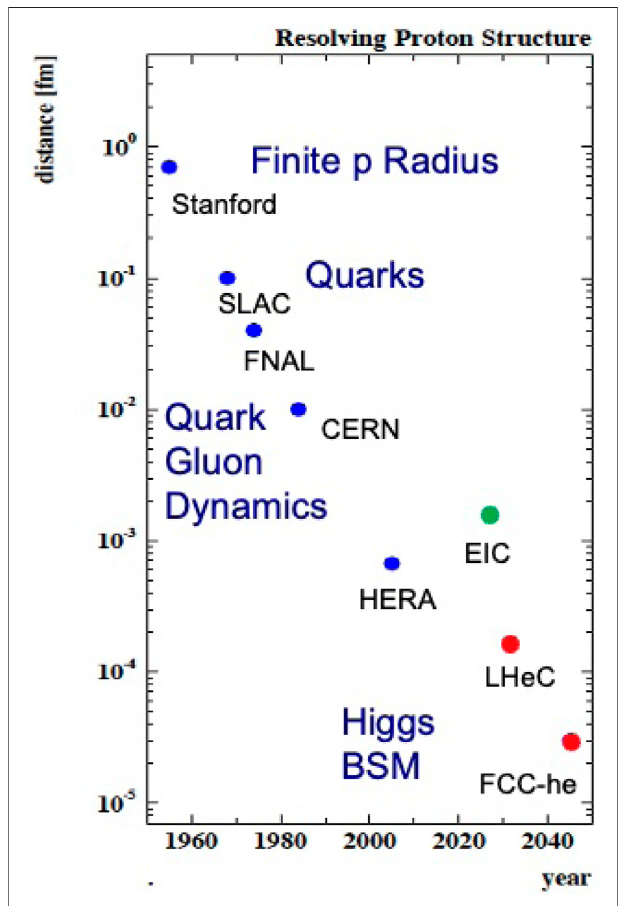
FIGURE 4 | Resolving the proton structure: EIC marked in green with spin resolution and the LHeC and FCC-eh colliders marked in red as potential future colliders [76]. The resolving power is directly related to the maximum 1/ Q 2 achievable at the respective facility. Note: Q 2 is the square of the momentum transferred by the electron to the